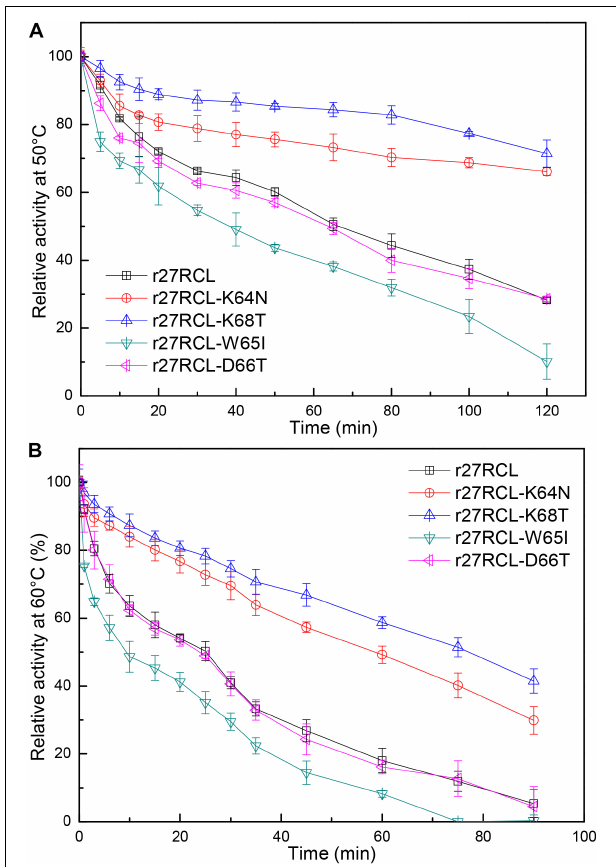
changes in the secondary structure of Lipr27RCL. CD